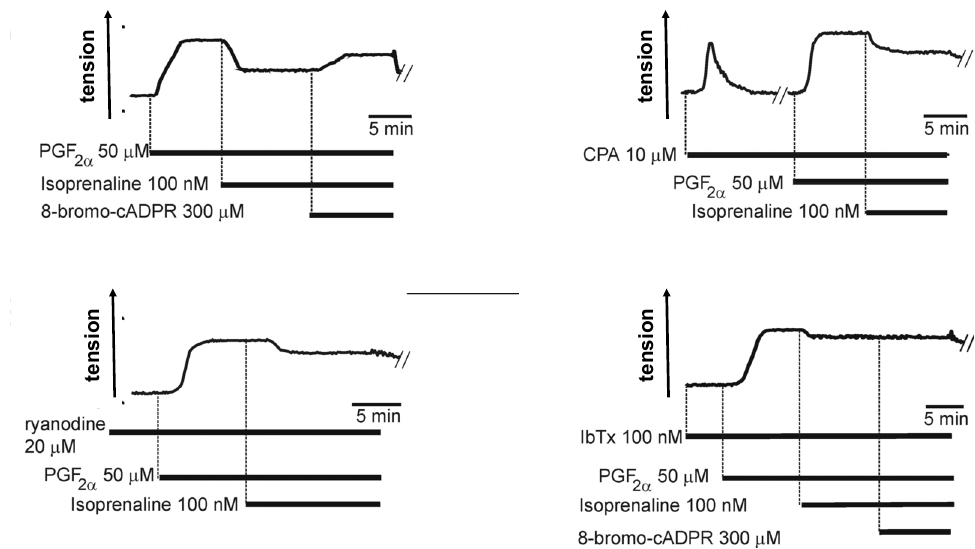
Figure 3. Example records show that the cADPR antagonist 8-bromo-cADPR ( top left ), ryanodine receptor block with ryanodine ( bottom left ) and depletion of sarcoplasmic reticulum calcium stores with cyclopiazonic acid (CPA; top right ) attenuates (~60%) pulmonary artery dilation induced by Isoprenaline. Blocking BK Ca channels with iberiotoxin delivers ~90% attenuation ( bottom right ).